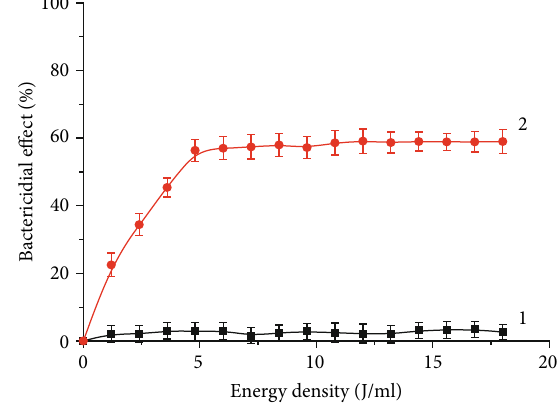
Figure 4: Bactericidal e ff ect of red light (660nm) (1) and methylene blue (10 -4 wt. %) activated by red light (660nm) (2) in suspension of wild strains S. aureus ( M ± SD